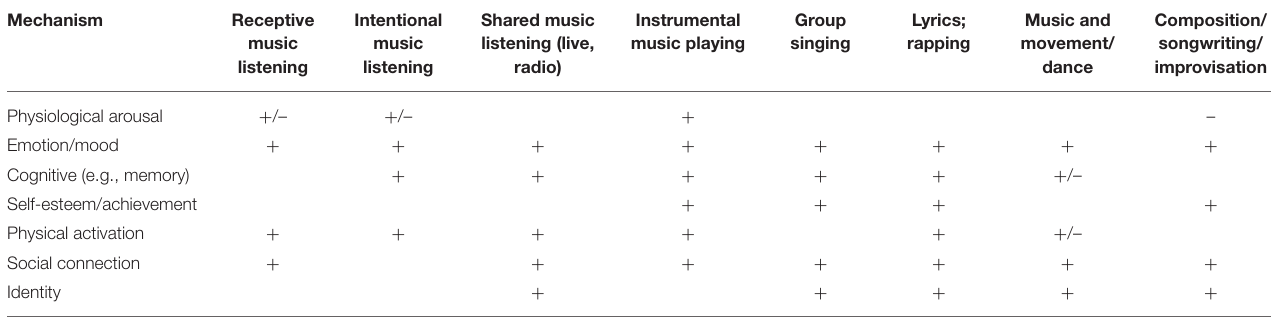
TABLE 2 | Summary of available evidence about the psychosocial mechanisms by which music activities affect health and well-being.